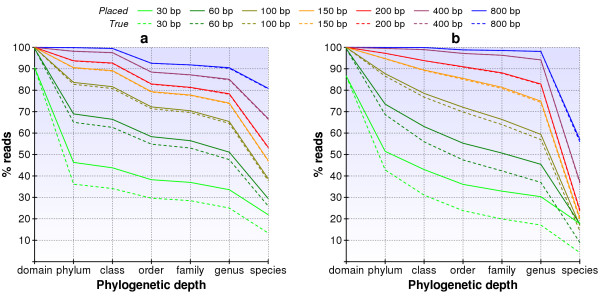
Simulated read resolution for varying read-lengths in diverse and representative samples. Simulation results are presented for (a) a diverse set of 387 bacteria and (b) 330 species representative of our samples. Simulated reads had a 20% standard deviation in read-length and a 1% sequencing error rate. Solid lines show assignments made by our methodology, while dashed lines show the proportion that are correctly assigned.